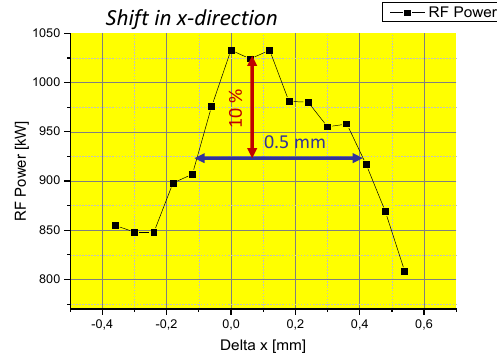
Fig. 4. Influence of the electron beam deviation (x-direction) on the RF power measurements carried out on the SP gyrotron .